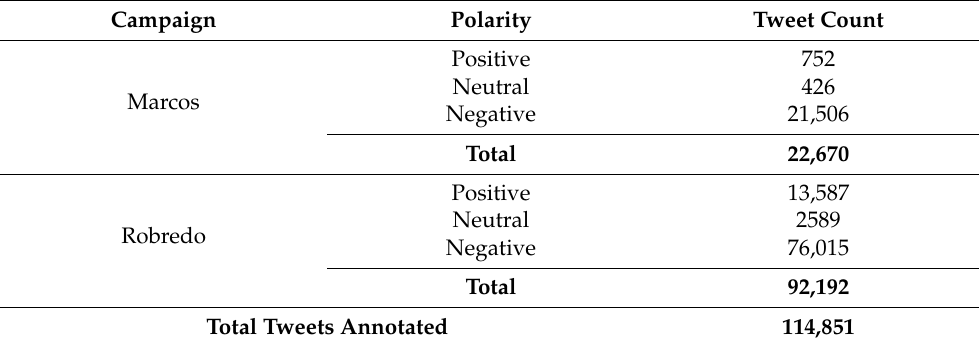
Table 4. Summary of tweets